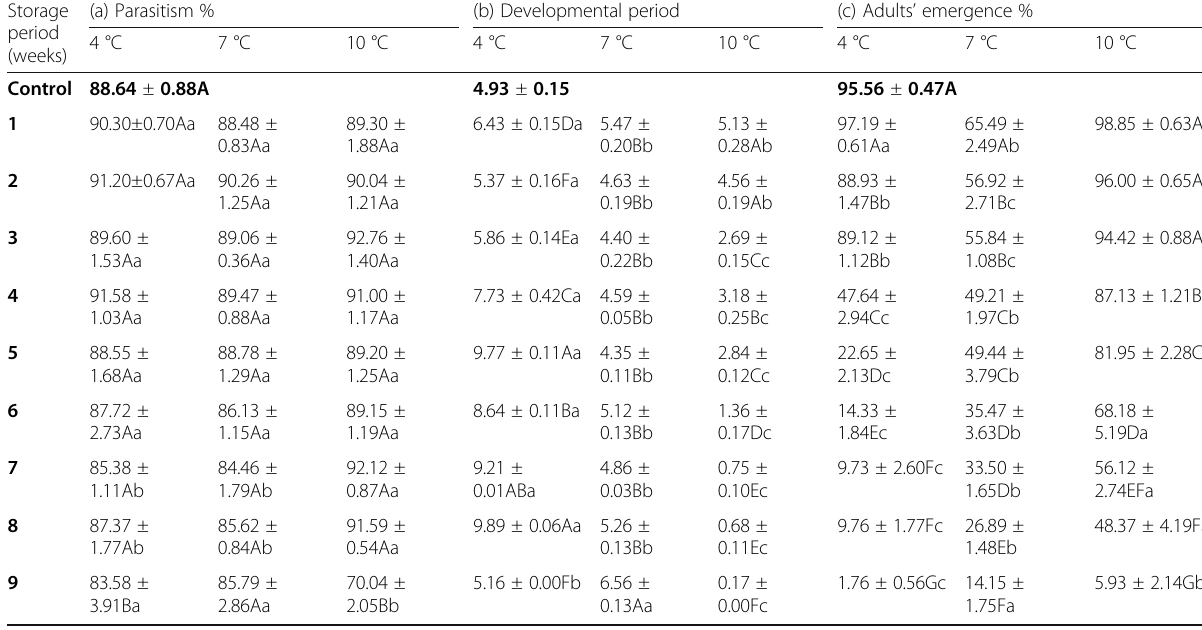
Means ± SE sharing the same capital letters in the same columns, and same small letters in the rows are statistically insignificant ( P ≥